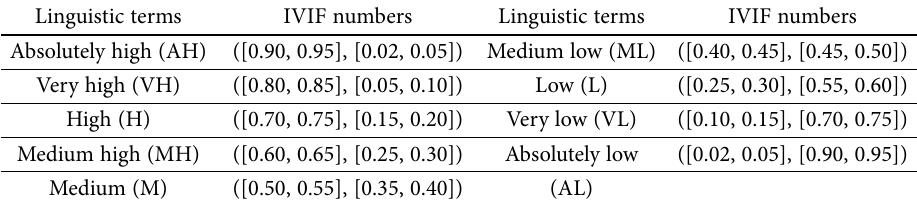
Table 1. Linguistic variables and their corresponding IVIF